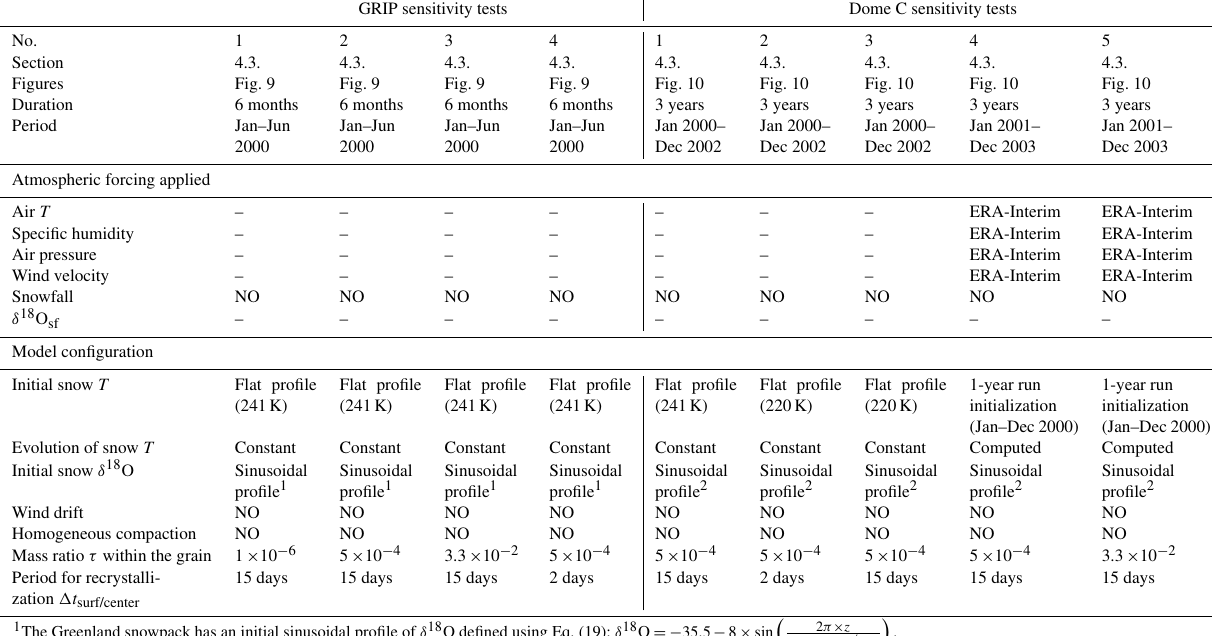
Table 5. List of the sensitivity tests performed at GRIP and at Dome C. The external atmospheric forcing used for Dome C is ERA-Interim reanalysis (see Table